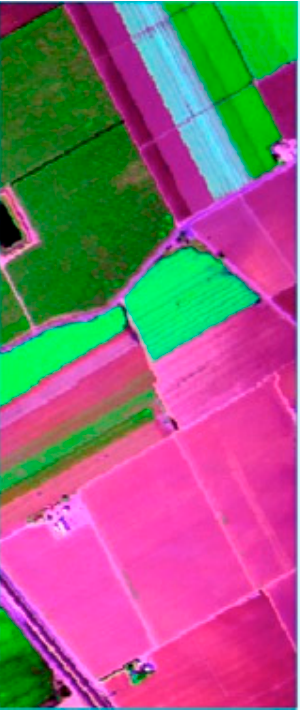
Figure 8. The false color composite image (15, 100 and 180 bands) of the Salinas dataset contained 224 spectral bands with a spatial resolution of 3.7 m and was acquired by the AVIRIS sensor over Salinas Valley, California, USA.